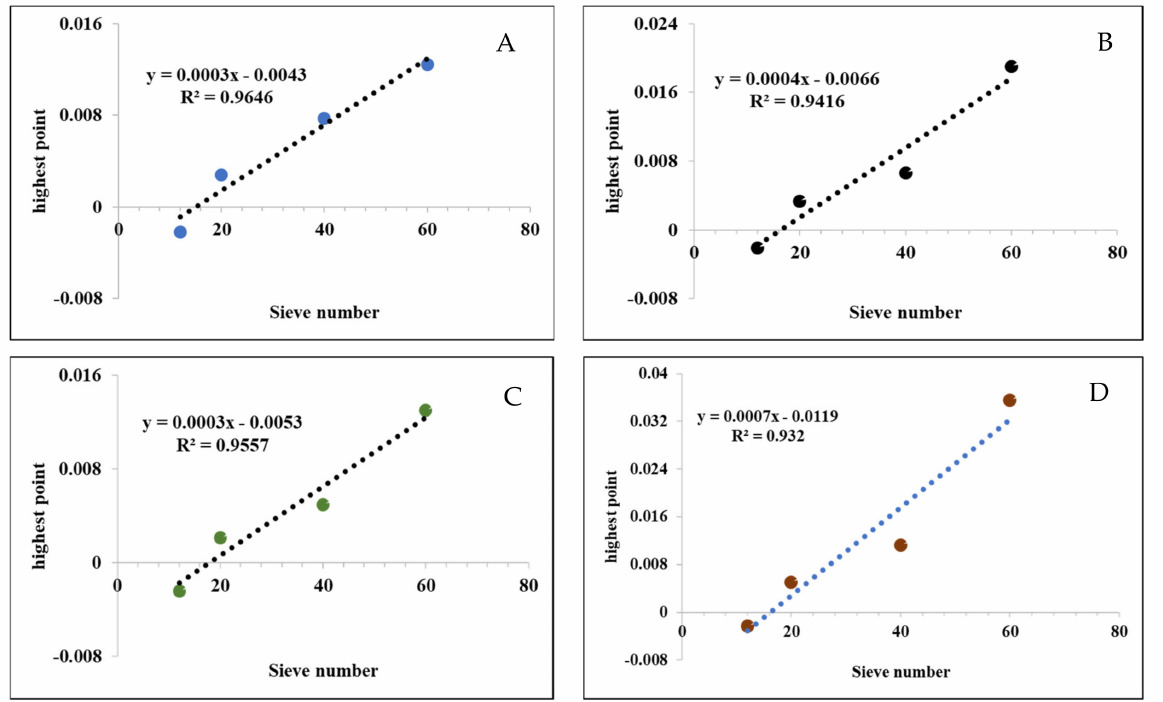
Figure 5. Numerical materialization of the intensity of the most representative signals of the FT-IR spectrograms as a function of particle size. ( A ) hydroxyl groups (O-H); ( B ) carbonyl group (C=O); ( C ) methylene group (CH 2 ); ( D ) carboxyl group